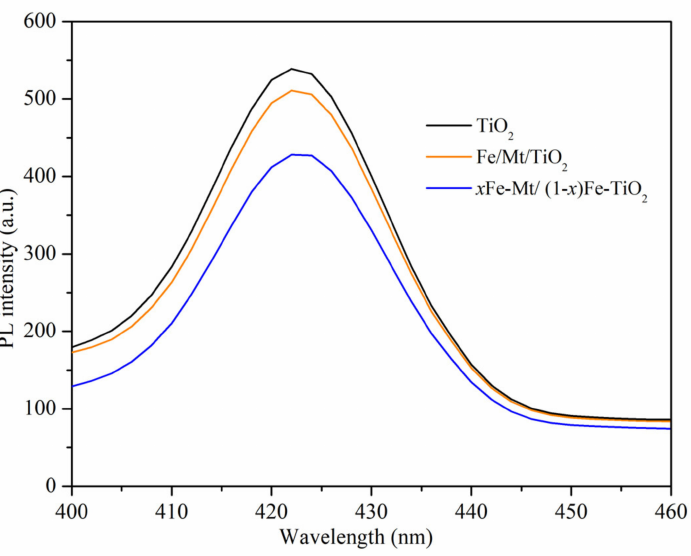
Figure 7. Photoluminescence of Fe/Mt/TiO 2 and x Fe-Mt/(1 − x )Fe-TiO 2 at 70 ◦